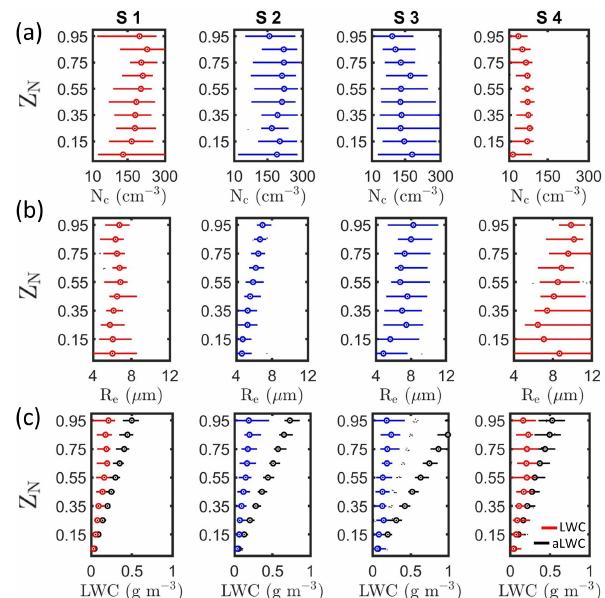
Figure 6. Vertical profiles of (a) N c , (b) R e , and (c) LWC and aLWC as a function of Z N for the four sawtooth maneuvers. Maneu- vers with contact (separation) between the biomass burning aerosol layer and cloud tops shown in blue